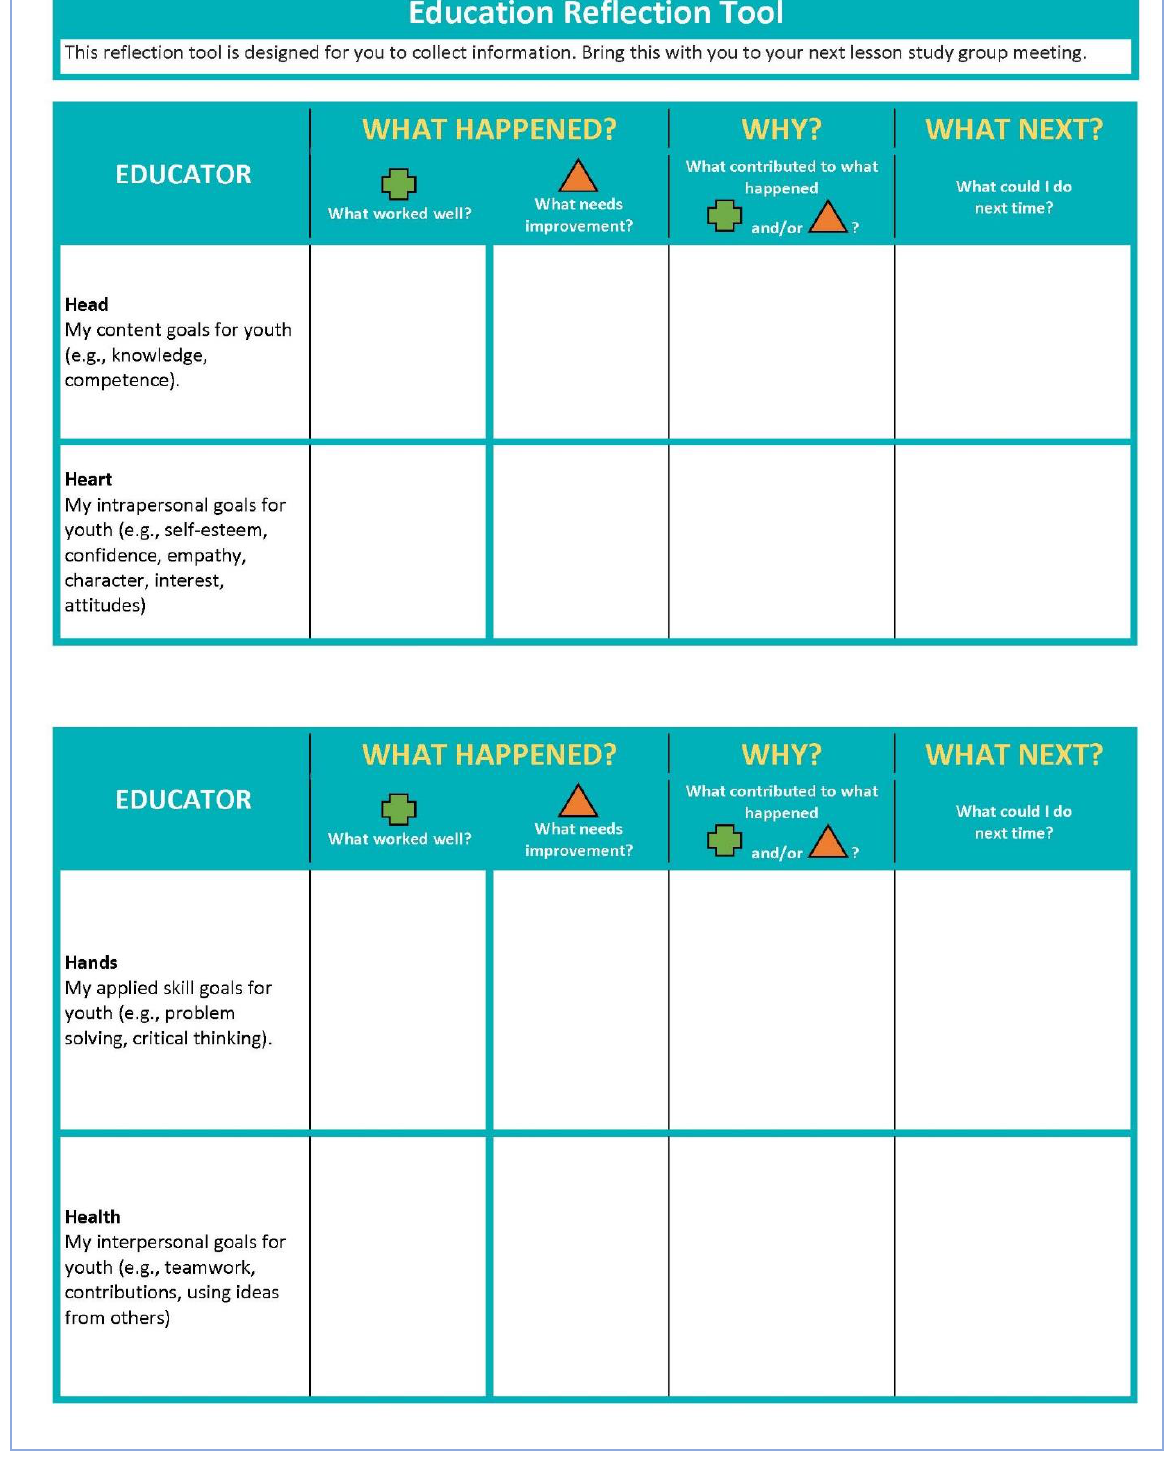
Figure B1. Educator Reflection